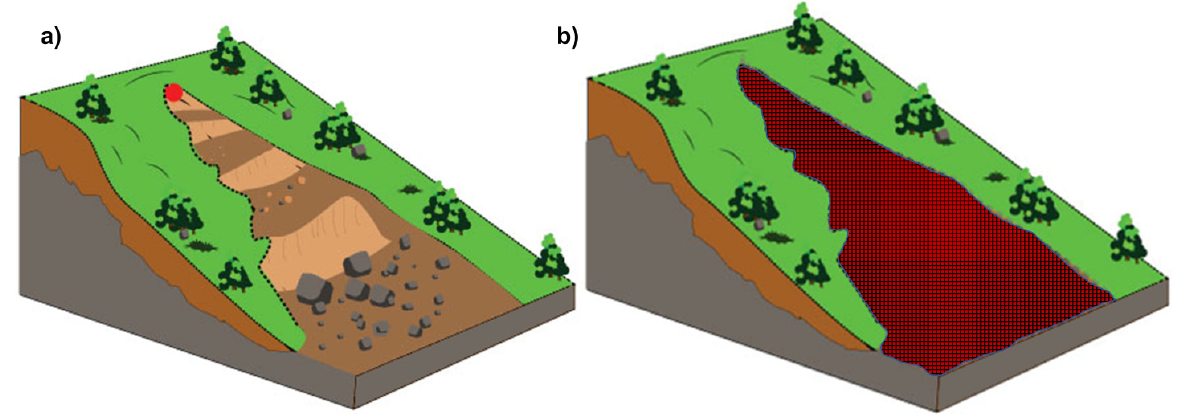
Figure 2. Different sampling strategies adopted in this study: ( a ) point data, and ( b ) polygon data.